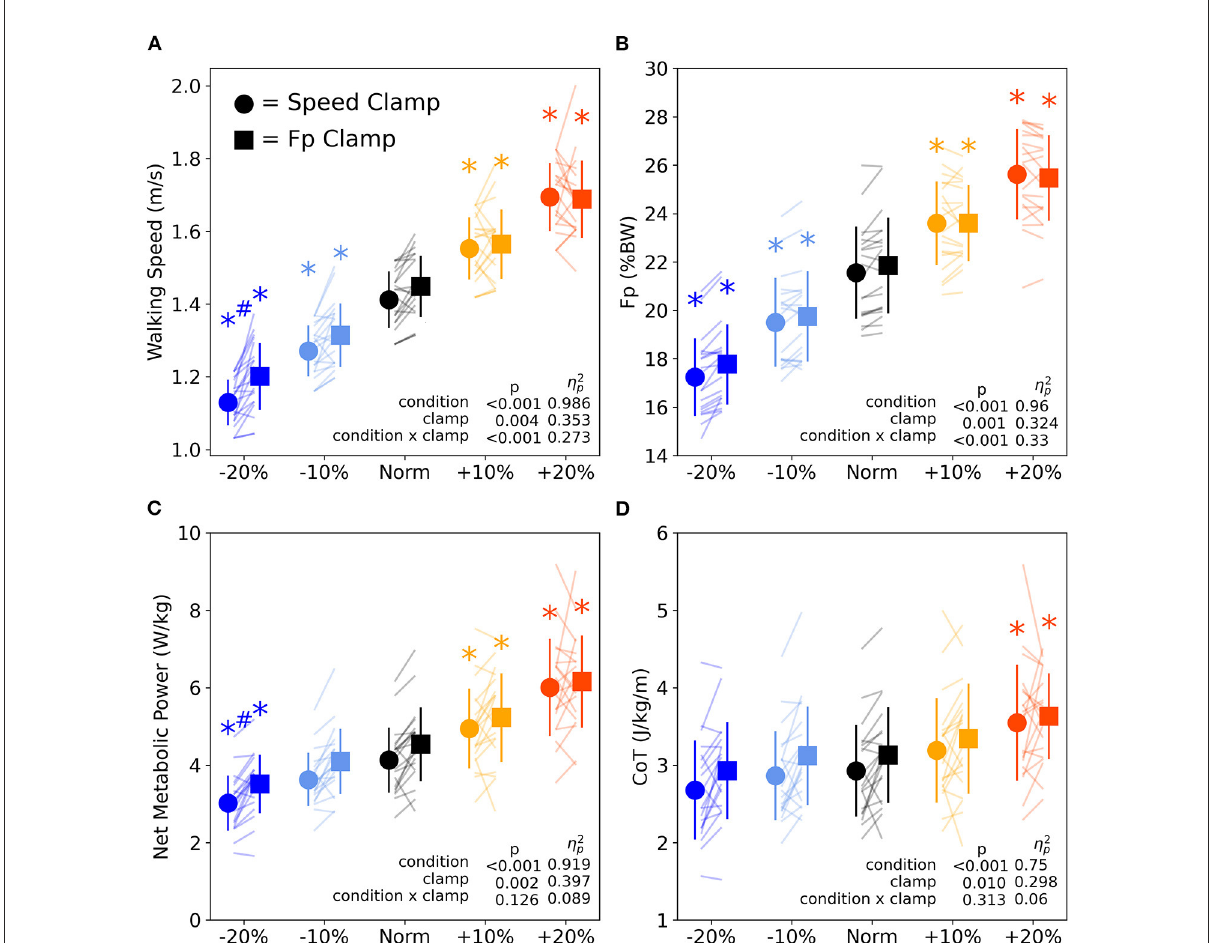
FIGURE6 Walking speed (A) and F P (B) across condition intensities for speed clamp and F P clamp trials. Walking speed and F P similarly increased and decreased with condition intensity. However, at the lowest condition intensity ( − 20%), particpants walked at faster speeds while extering the same F P . Walking net metabolic power (C) significantly changed with condition intensity except for the − 10% condition intensity. Walking cost of transport (D) only significantly increased for the + 20% condition intensity. Asterisks ( * ) indicate a significant pairwise post-hoc difference ( p < 0.05) from the Norm condition. Hashtags (#) indicate a significant pairwise post-hoc difference ( p < 0.05) between clamp types (speed vs. F P ). BW, body